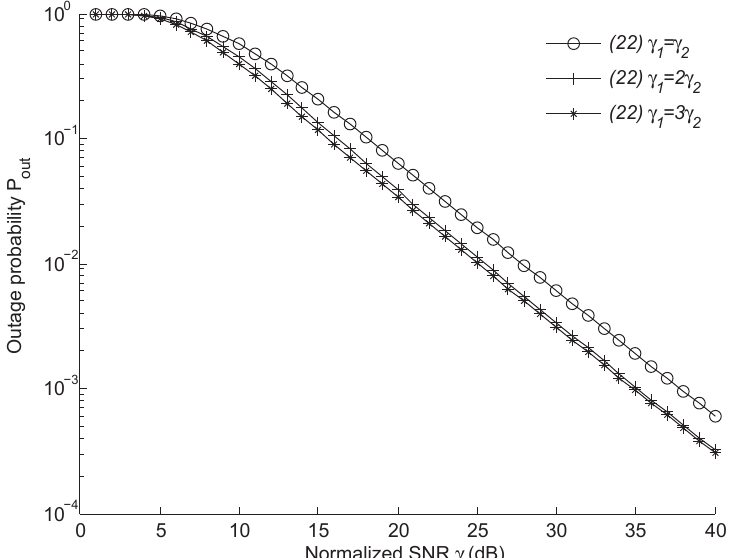
Figure 5. Outage probability vs. different outage threshold γ th for γ = 8 and 16, A 2 = 1/ h 2 + N ) . A 2 = 1/ ( h 2 0 1